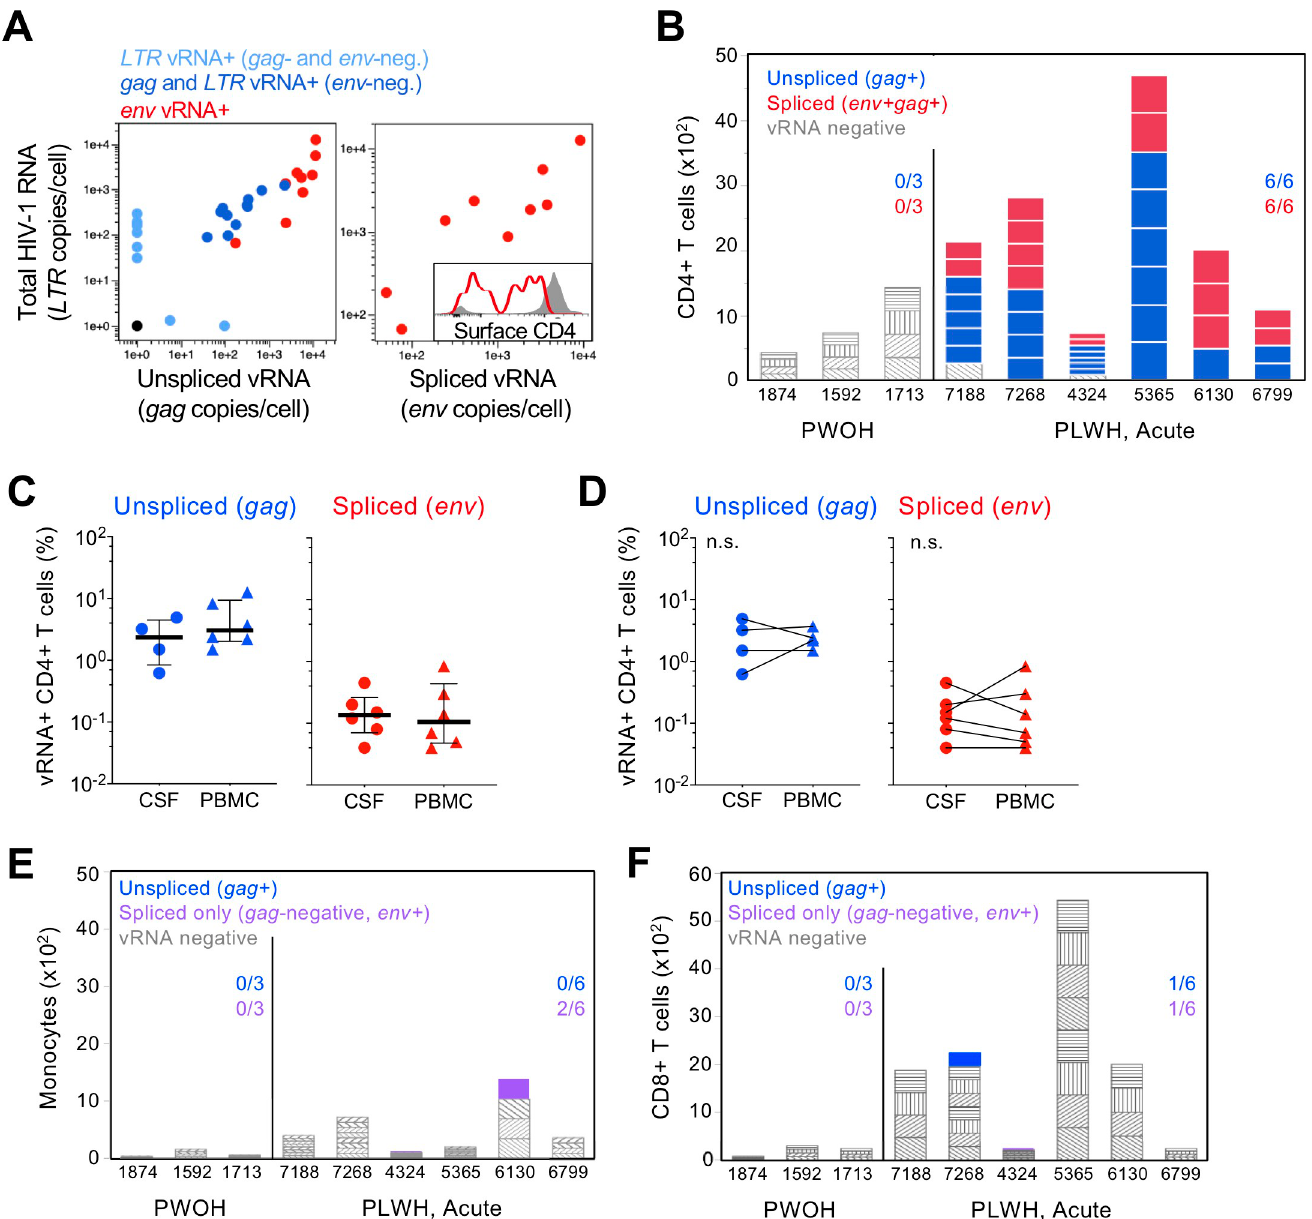
Fig 4. HIV-1 infection of CD4+ T cells in CSF during acute infection in humans. (A) Single-cell analysis of vRNA content in memory CD4+ T cells from PBMC of an acutely infected PLWH from the RV254 cohort. CRF01_AE HIV-1 mRNA was measured by RT-qPCR using assays specific for LTR, gag , and env in cells FACS sorted at one per well. Each symbol depicts vRNA content for one cell. Symbol color represents the combination of vRNAs detected in the cell, as indicated in the key. Surface CD4 protein expression for env vRNA+ cells (red line) was measured by flow cytometry and is indicated relative to vRNA-negative cells (gray) in inset. (B) HIV-1 vRNA RT-qPCR positivity among CD4+ T cells isolated by flow cytometry from CSF of PWOH and people living with acute HIV-1. Bars indicate the number of cells analyzed for each individual; stacked bars reflect the size of each replicate pool of CD4+ T cells. Bar coloring indicates HIV-1 vRNA positivity for unspliced (blue, gag ) or spliced plus unspliced (red, env and gag ) mRNA; vRNA-negative replicates are colored gray. (C) Distribution of HIV-1 gag (left) and env (right) vRNA+ CD4+ T cell frequency in CSF and PBMC is shown for individuals represented in (B). HIV-1 gag vRNA+ CD4+ T cell analysis in CSF was limited to four individuals. Bars indicate median values and whiskers span the interquartile range. (D) Paired analysis comparing the infected CD4+ T cell frequency between CSF and PBMC is shown. Significant differences between tissues was assessed using Wilcoxon matched-pairs rank test. (E) HIV-1 vRNA positivity among monocytes and CD8+ T cells (F) isolated from CSF as in (B); purple, env+ and gag -negative. Fraction of individuals with vRNA+ cells is indicated.